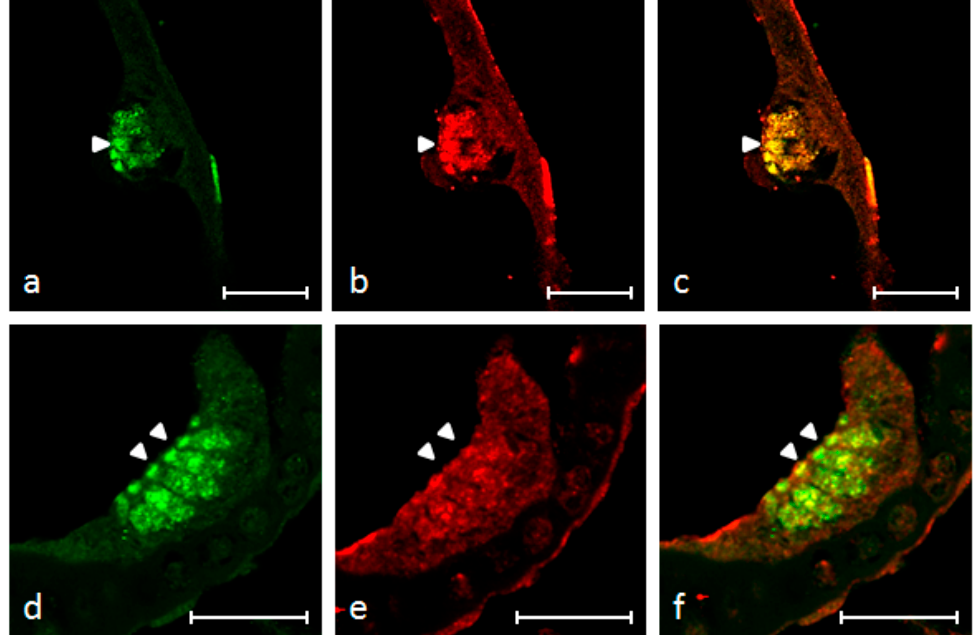
Figure 7. Inner ear of zebrafish larva 8 dpf: immunohistochemical detection of proBDNF ( a ), trkB ( b ) and colocalization of both antibodies ( c ) in utricular macula; Immunohistochemical detection of proBDNF ( d ), trkB ( e ) and colocalization of both antibodies ( f ) in lateral crista. Immunoreactivity was found